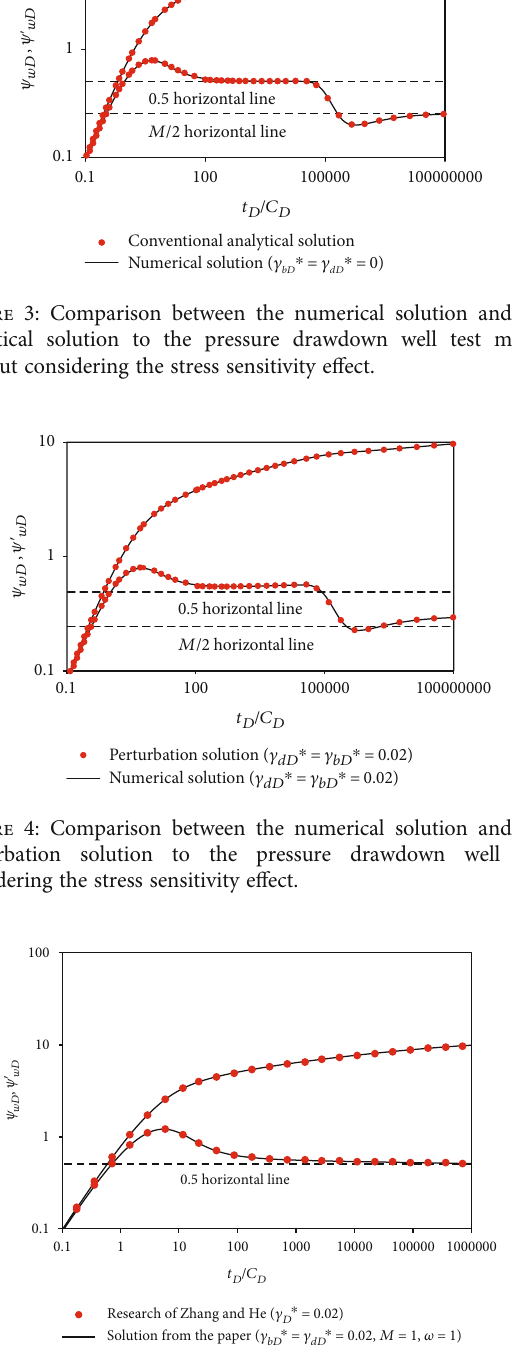
Figure 5: Comparison of the homogeneous gas reservoir pressure buildup well test curve obtained from the paper and the research of Zhang and He.